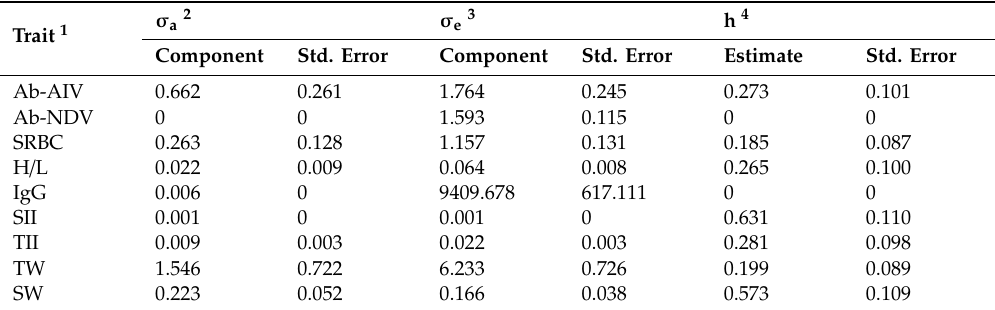
Table 2. Genetic parameters estimated from all data with the best linear unbiased prediction (BLUP)